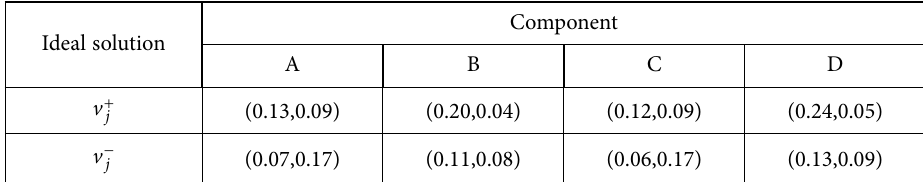
Table 12. Ideal solutions for comparative performance and diversity